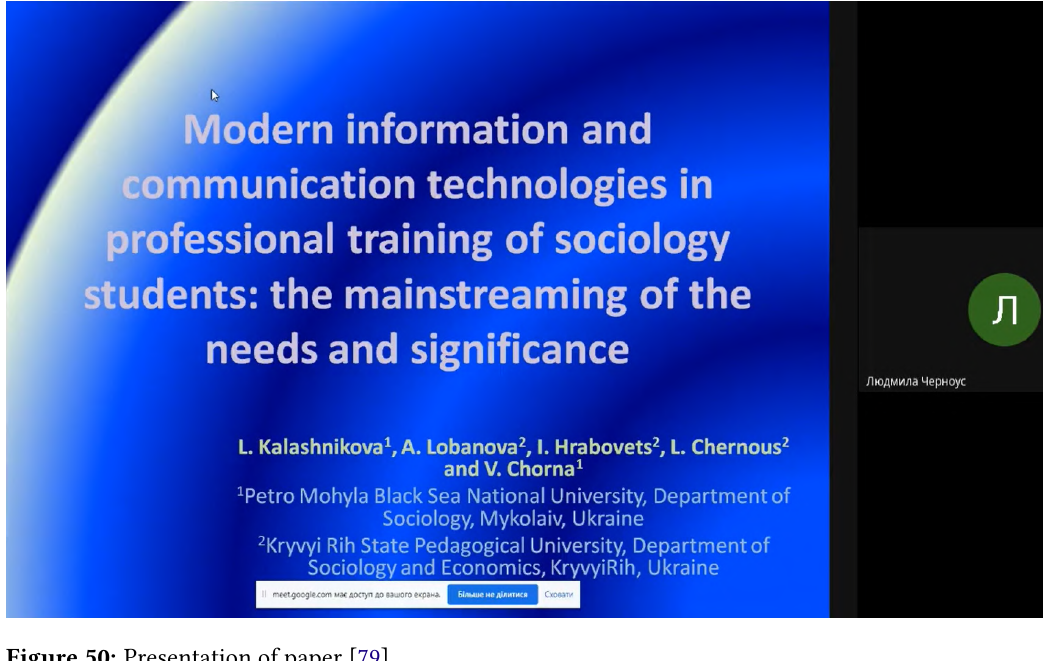
Figure 50: Presentation of paper